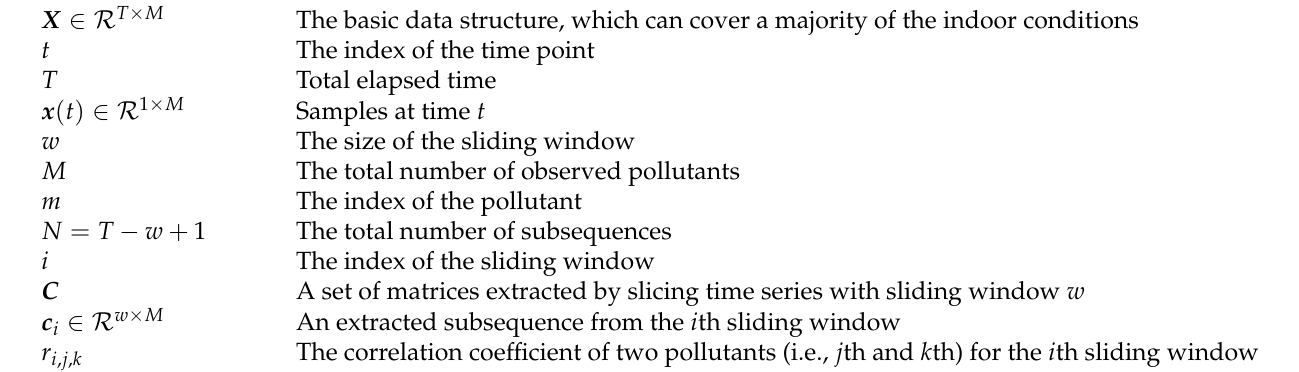
Table 2. A summary of the notation used in this